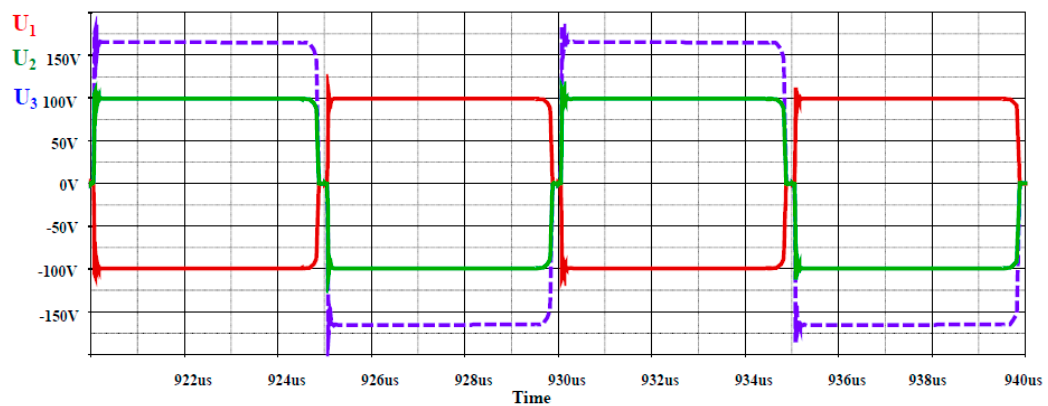
Figure 13. Voltage waveforms on the inductors L 1 – L 3 (100% of output power)—Simulation.